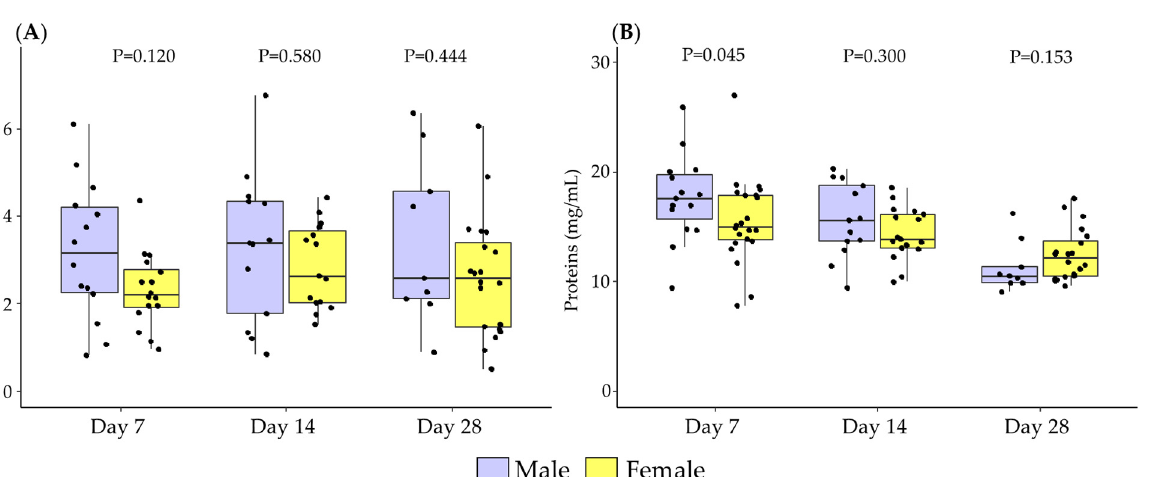
Figure 2. The evolution of breast milk total antioxidant capacity via the ABTS method ( A ), and by FRAP method ( B ) during the first month of lactation according to the sex of the newborn. Data show median and interquartile range [Q1; Q3]. Neonatal sex was compared according to the day of lacta- tion using the Mann-Whitney U test and extracted p -Value ( p ) adjusted by Holm-Bonferroni multi- ple comparison methods was reported in the figure. TE: Trolox equivalent. Regarding low molecular weight antioxidants, GSH was significantly higher in male BM at day 7 and day 14, without significant difference at day 28 (Figure 3A). Total thiol groups showed no significant differences between BM from mothers with a male and fe- male newborn in any of the points studied (Figure 3B).